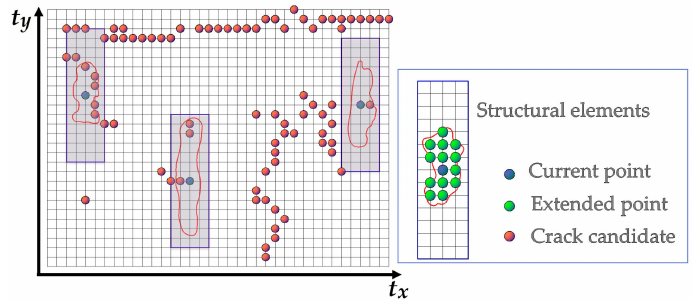
Figure 9. The structural elements of the morphological closing